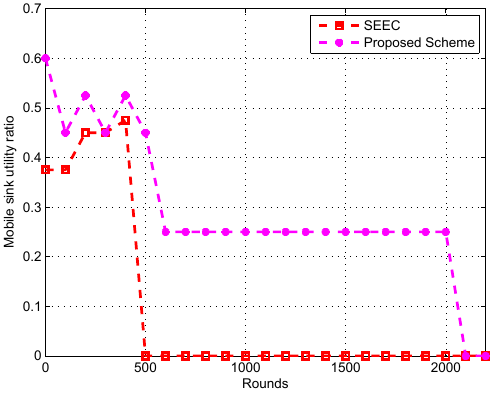
Figure 6. Mobile sink utility ratio.